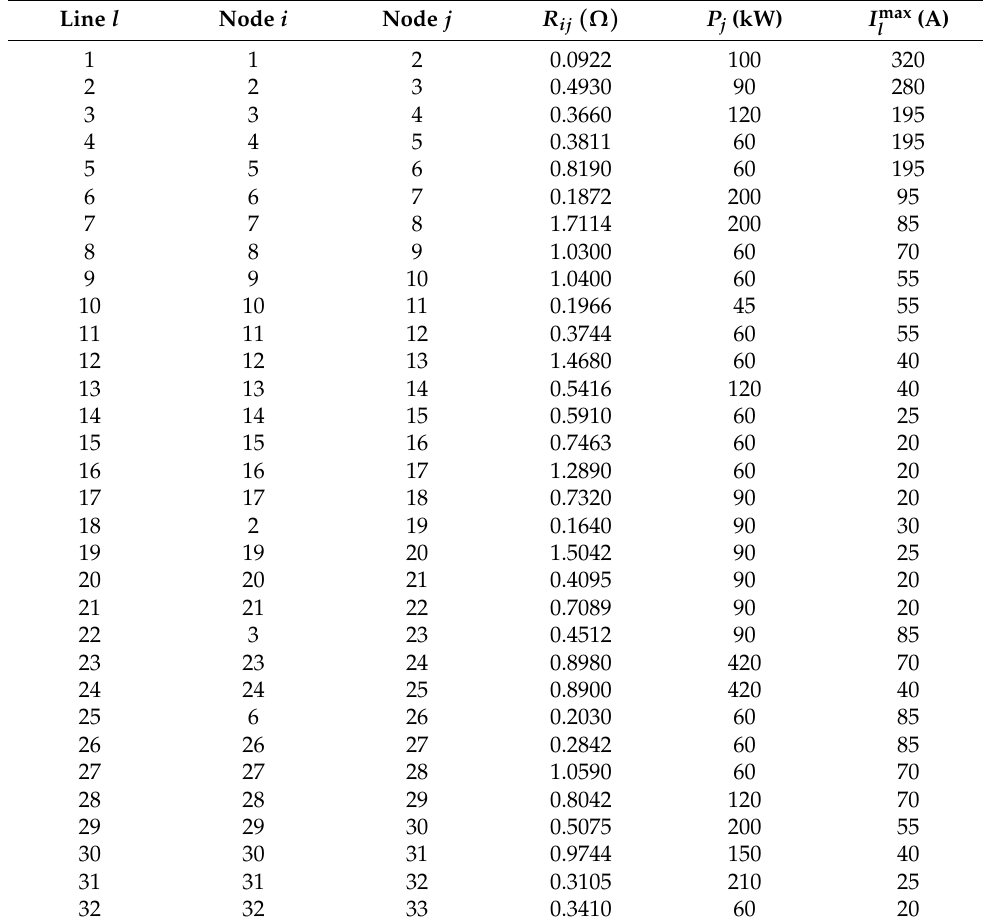
Figure 2. Urban distribution network composed of 33 nodes. This test system includes three PV sources located at nodes 12, 15, and 31, with a nominal power of 2400 kW. In addition, it operates with a nominal voltage of 12.66 kV at the terminals of the substation. The parametric information regarding the loads and branches of the 33-bus grid is presented in Table 1. Table 1. Parametric information of the urban distribution